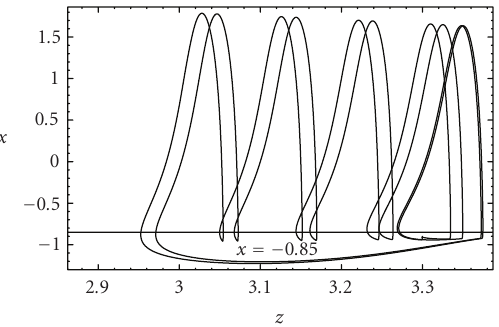
Figure 2.16. Projection of the three-dimensional trajectory onto the zx -plane ( I = 3 . 25, r = 0 . 005, and s = 4 . 0).